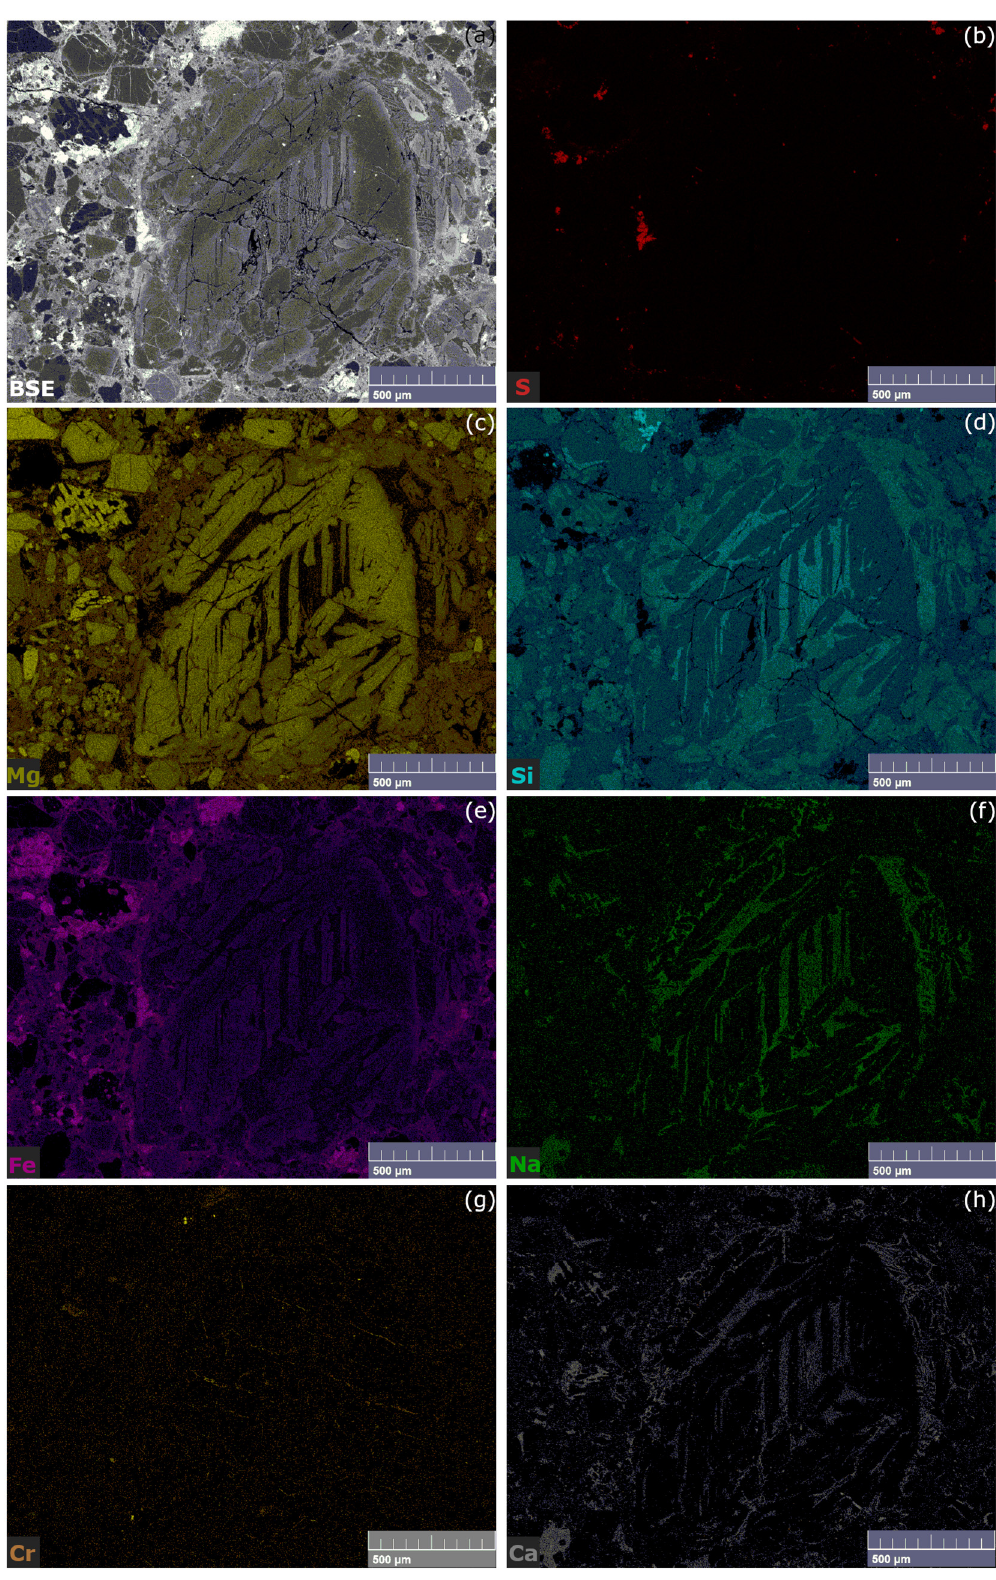
Figure 6. SEM-EDS results of chondrule B: ( a ) BSE image of the chondrule; ( b – h ) EM: (Red) S EDS map; (yellow) Mg EDS map; (blue) Si EDS map; (purple) Fe EDS map; (green) Na EDS map; (orange) Cr EDS map, (grey) Ca EDS map.